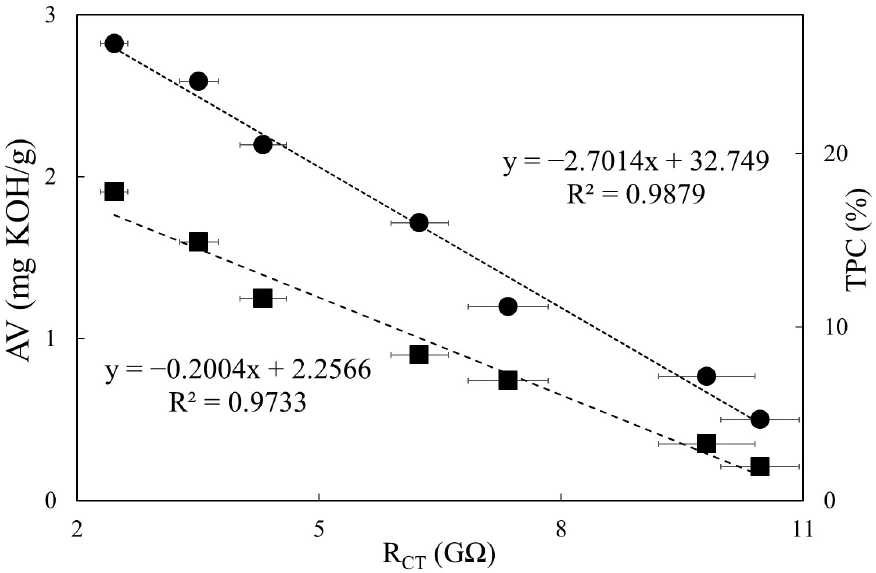
Figure 5. Comparisons of R CT with AV ( (cid:4) ) and TPC ( • ) during the 24 h deep-frying process. The R CT values were from Table 2; the AV and TPC values were both from Table 3.